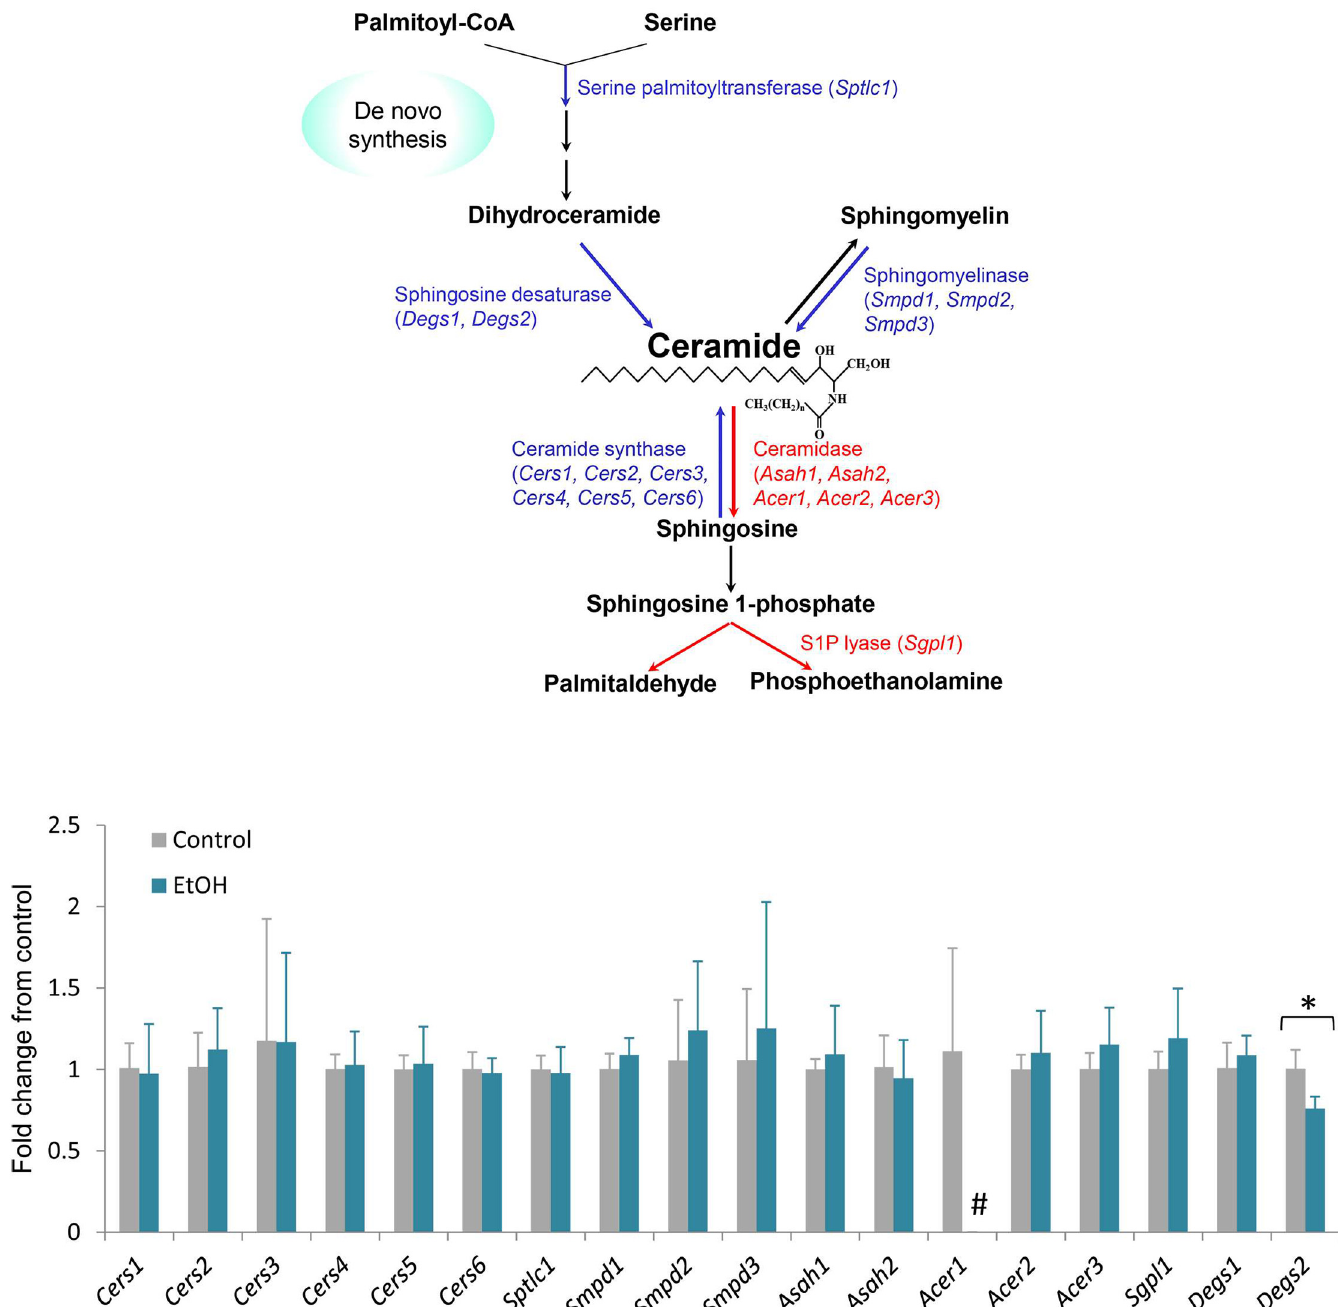
Fig 3. mRNA levels for genes encoding sphingolipid metabolic enzymes were determined in control and ethanol-exposed (EtOH) forebrain tissues by qRT-PCR. Expression was normalized to control rats. Error bars represent standard deviation. N = 4, * P < 0.05, # = not